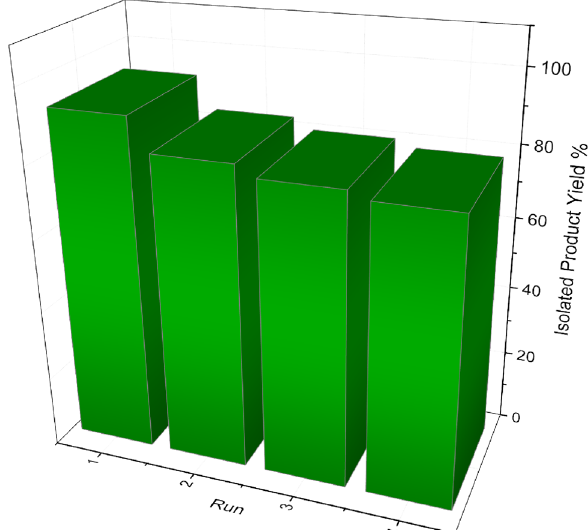
Figure 8. Recyclability of the Ag–CP.